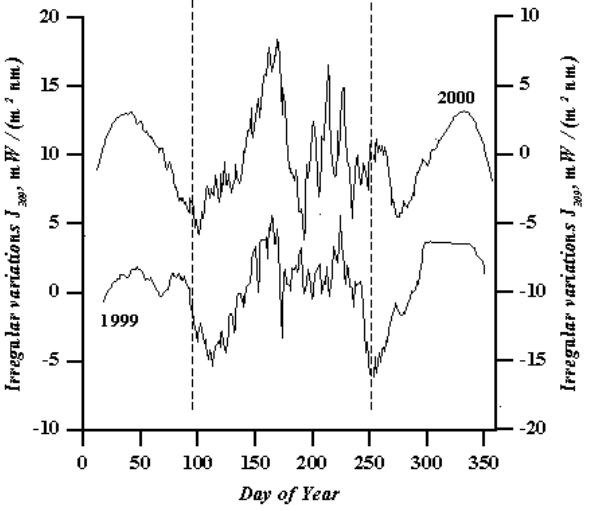
Fig. 3. The averaged year-to-year changes in the irregular UVR variations at 309nm for 1999 and 2000.